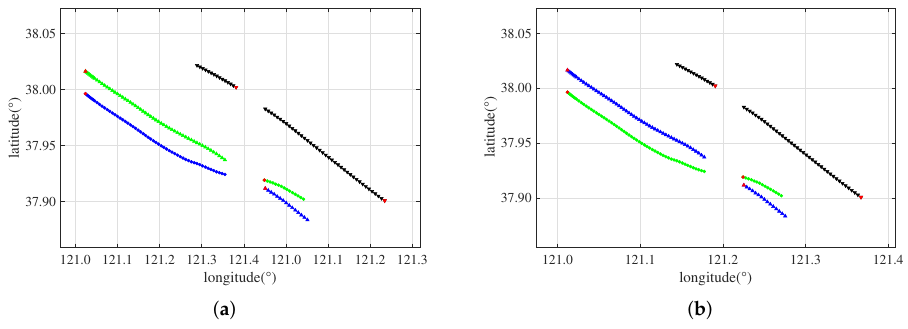
Figure 5. Tracklet association results. ( a ) The TSA method in [12]. ( b ) The proposed method.